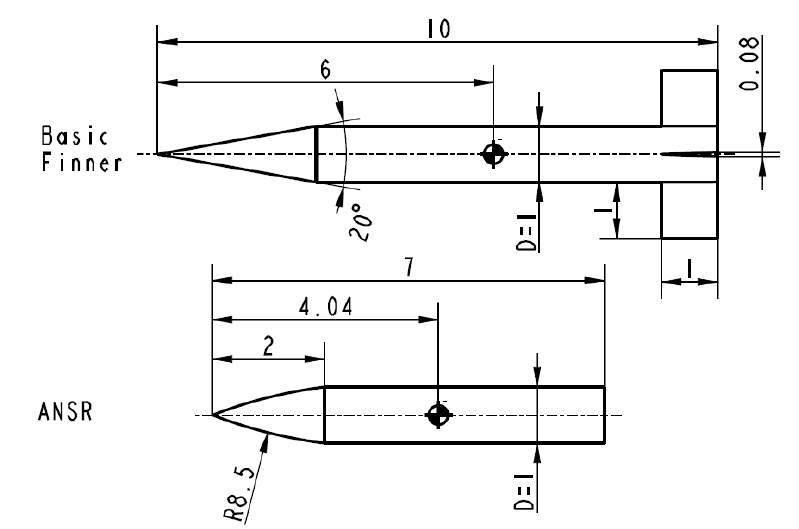
Figure 2. Basic Finner ( top ) and ANSR ( bottom ) – all dimensions referenced to